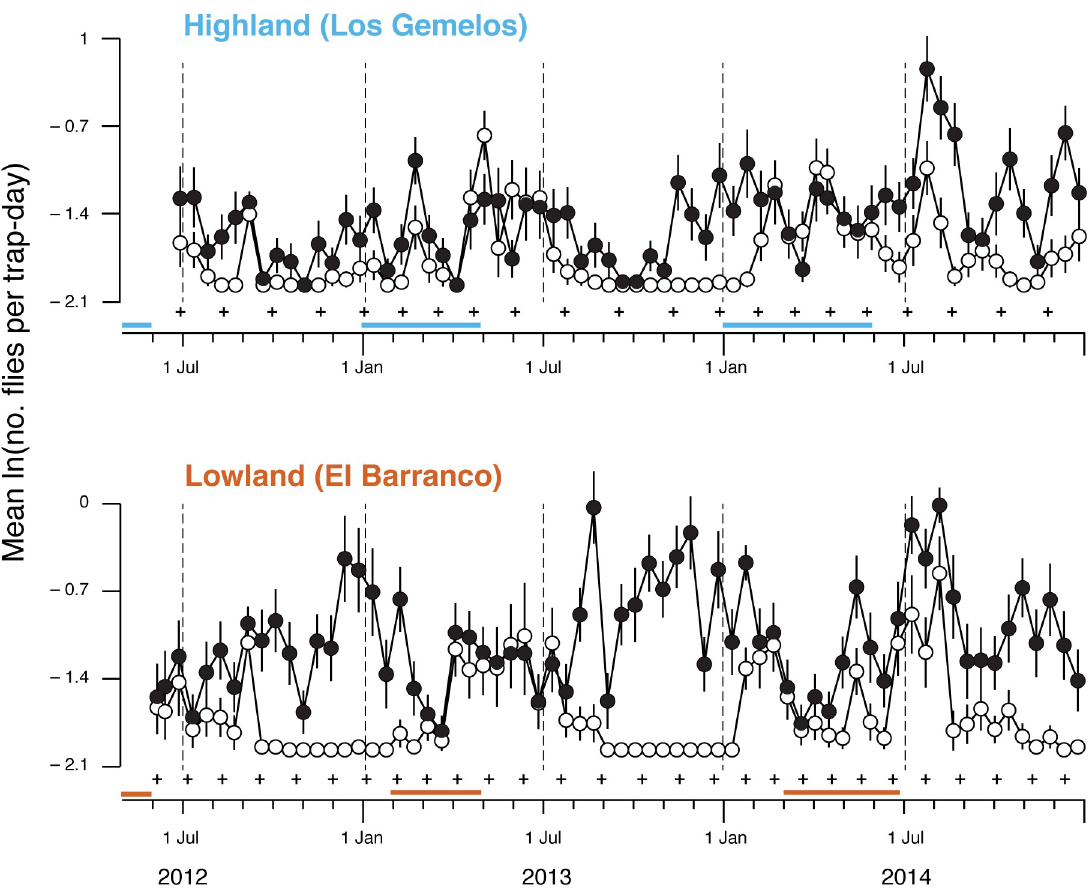
Fig 2. Catch rates of female (filled circles) and male (open circles) P . downsi at the highland and lowland sites, by date traps were emptied. Vertical bars around points are ± 2SEs of means (only visible when greater than symbol diameter), n = ~30 traps per point. Plus marks (+) delimit consecutive fly generations, estimated with a day-degree based generation time model. Horizontal bars above data scales represent breeding seasons of known hosts.